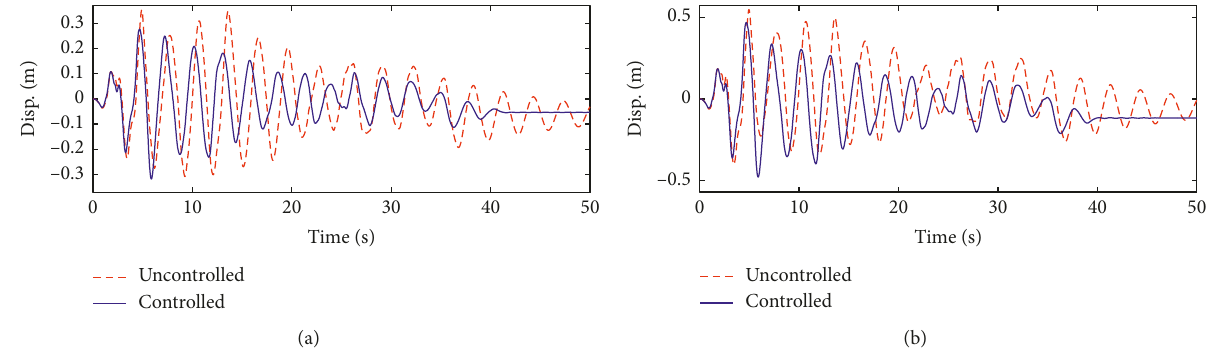
Figure 16: Top-story displacement-time histories of the structures under the action of the El Centro wave: (a) 0.3g conditions; (b) 0.51g